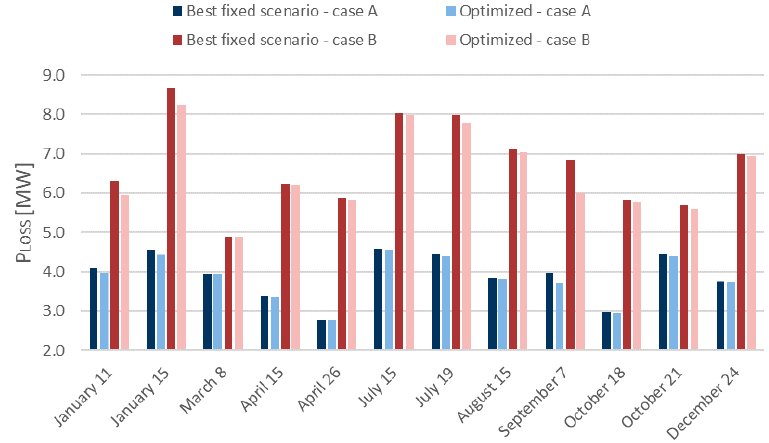
Figure 7. The comparison between daily losses in RTS 96 network, case A and case B.